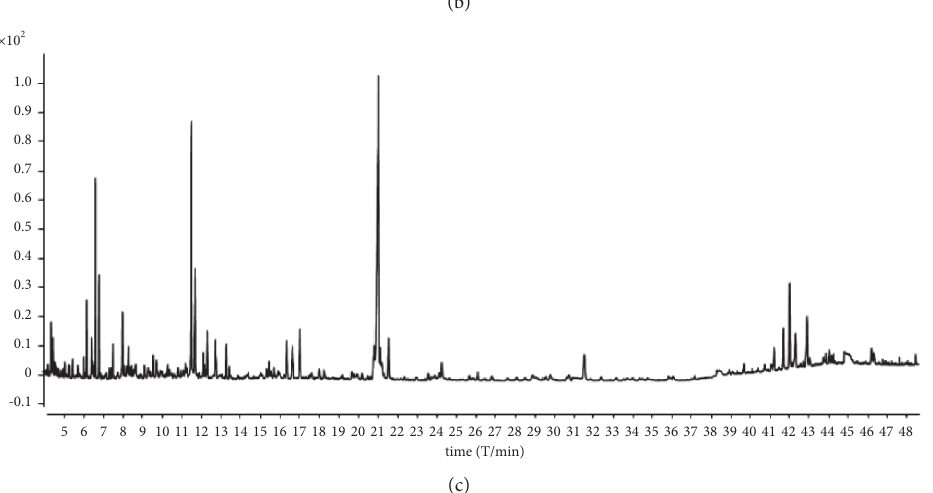
Figure 1: Total ion chromatograms of groups A (a), group B (b), and C. indicum sample (c) in the GC-MS full-scan